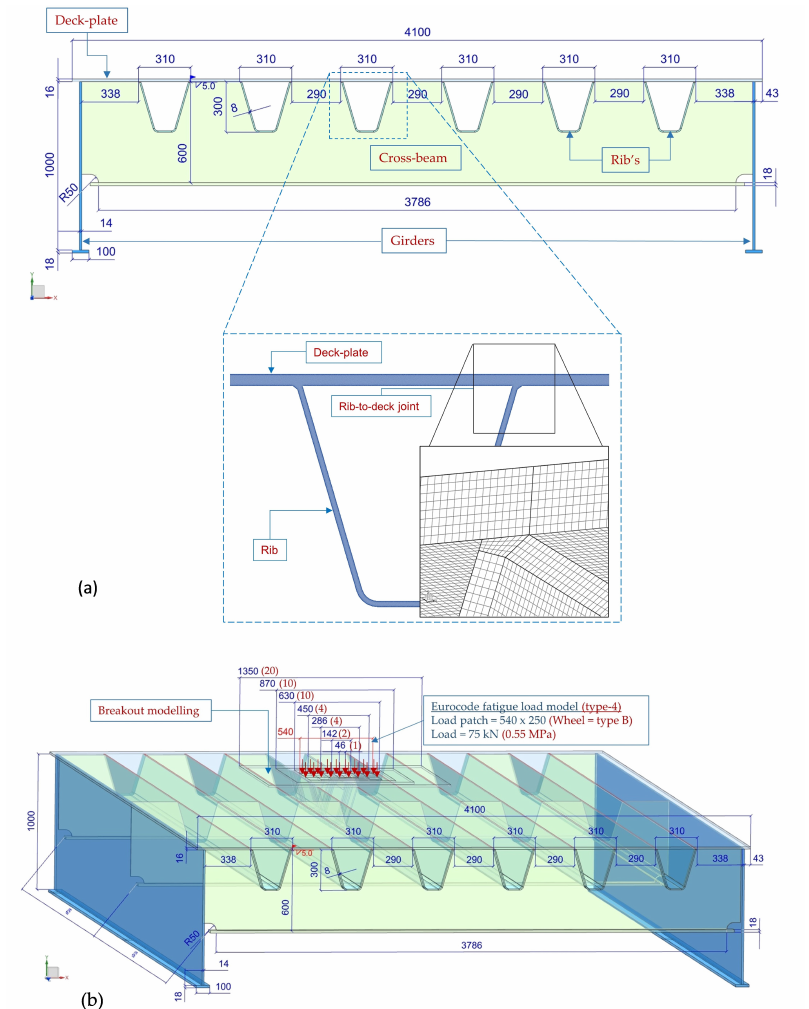
Figure 5. Details of the orthotropic steel deck specimen used in this study. ( a ) The cross-section of orthotropic steel deck specimen with rib-to-deck joint details. ( b ) 3D-Orthotropic steel deck specimen with breakout modelling and applied fatigue load model